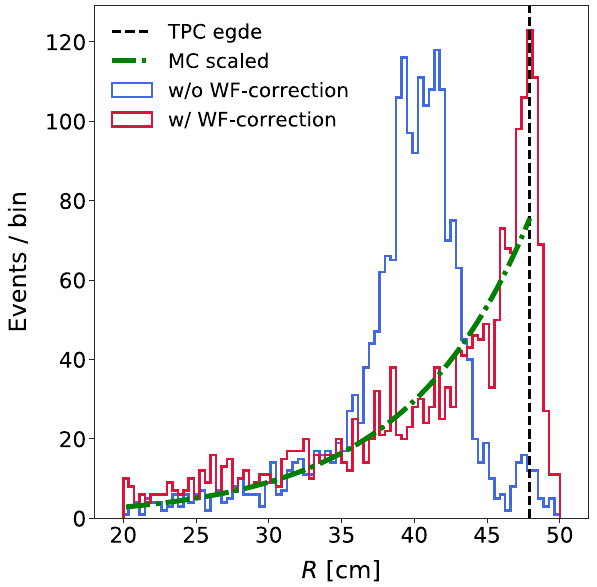
Fig. 3 Comparison of the radial position distribution of 208 Tl events from external 228 Th calibration, between data processed with (red) and without(blue)WFcorrection.Alsoshownherearethemaximumradius oftheTPC(black)andthedistributionofsimulated 208 Tlevents(green), scaled to fit the red distribution